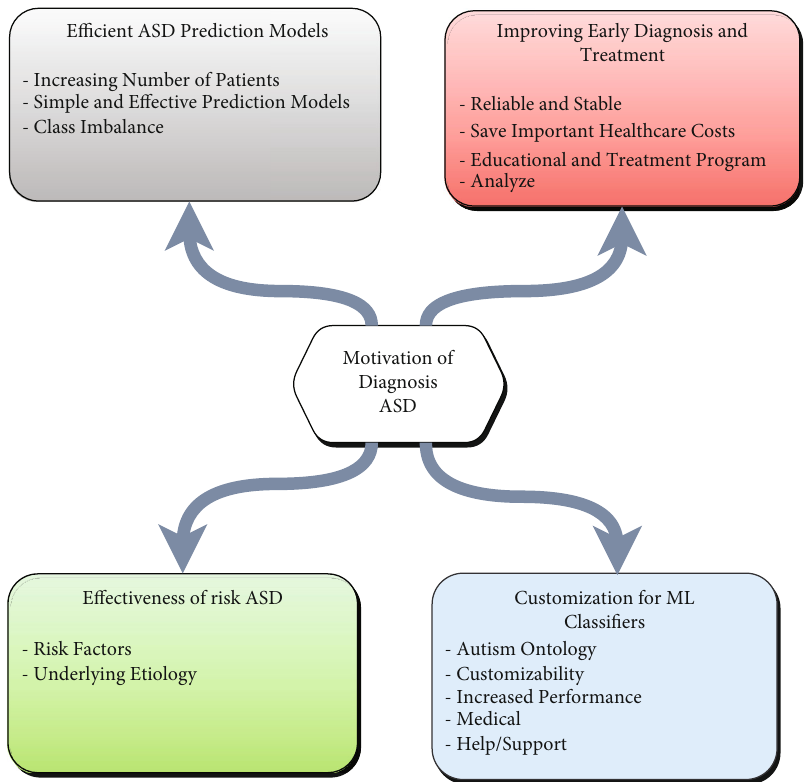
Figure 8: Motivation categories of diagnosis